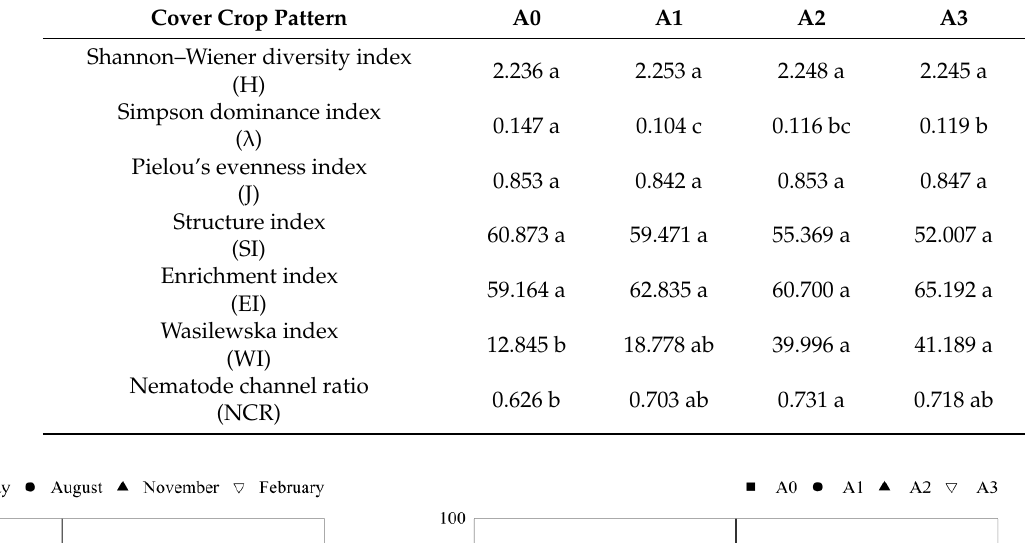
Table 2. Ecological indices of the nematode communities. Different lowercase letters indicate the significant differences between different cover crop patterns ( p < 0.05).